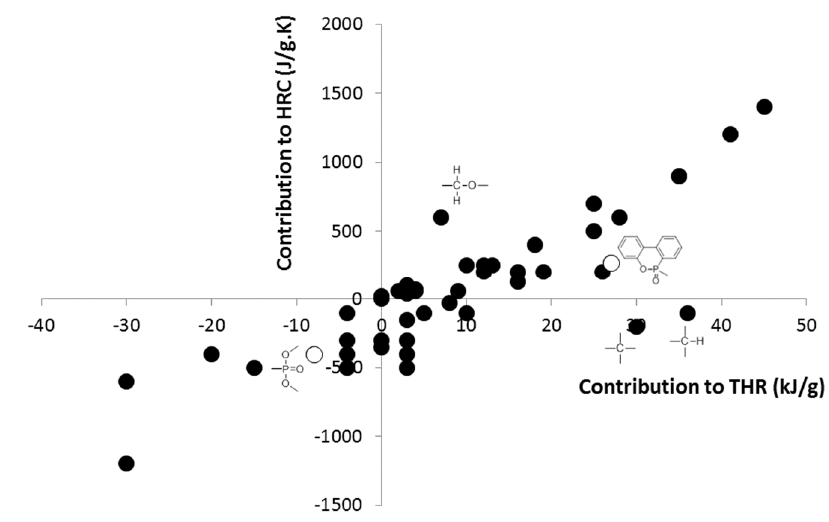
Figure 6. Contribution to HRC versus contribution to THR for 47 groups.